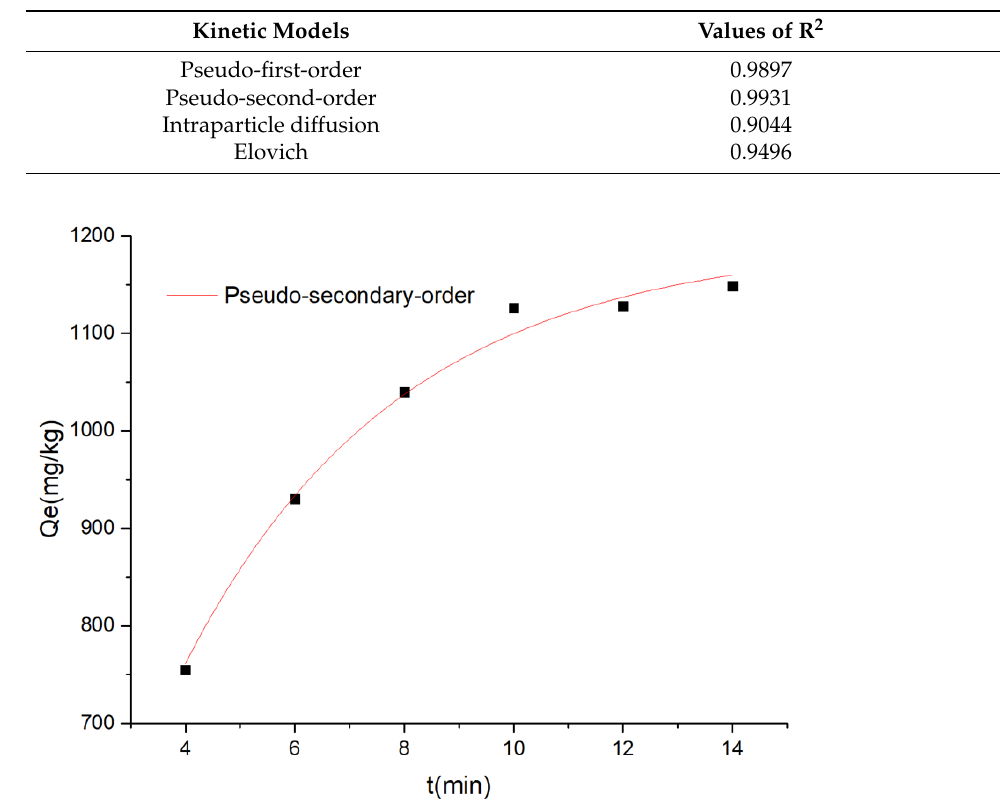
Figure 27. Study on the pseudo-secondary kinetics of carmine removal by rGO/Fe/Cu. Table 9. The R 2 values of the kinetics for carmine adsorption on rGO/Fe/Cu